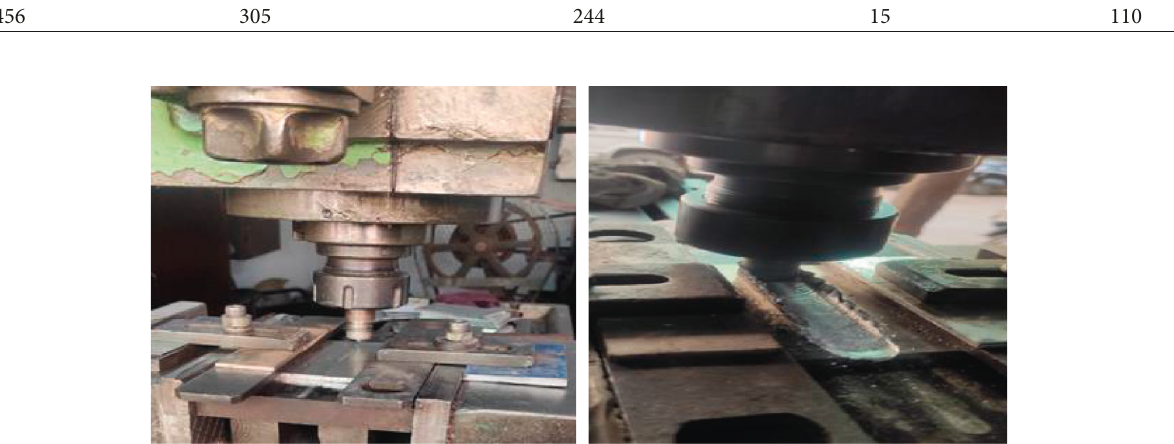
Figure 1: Friction stir welding process.